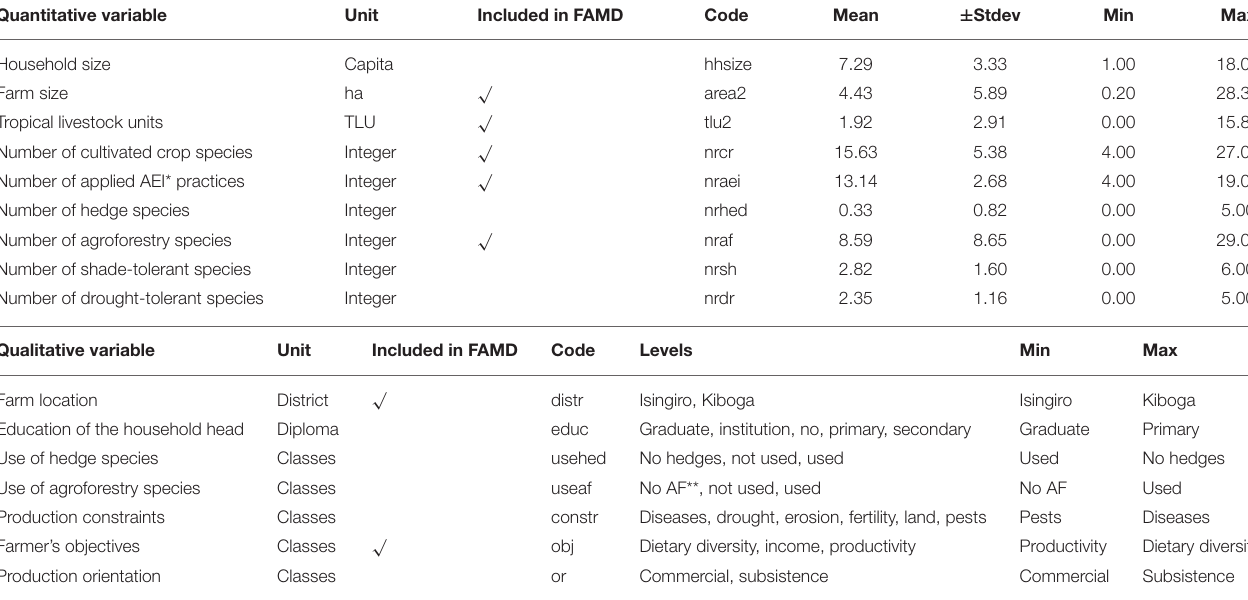
TABLE 1 | Main characteristics of the 16 key variables of the